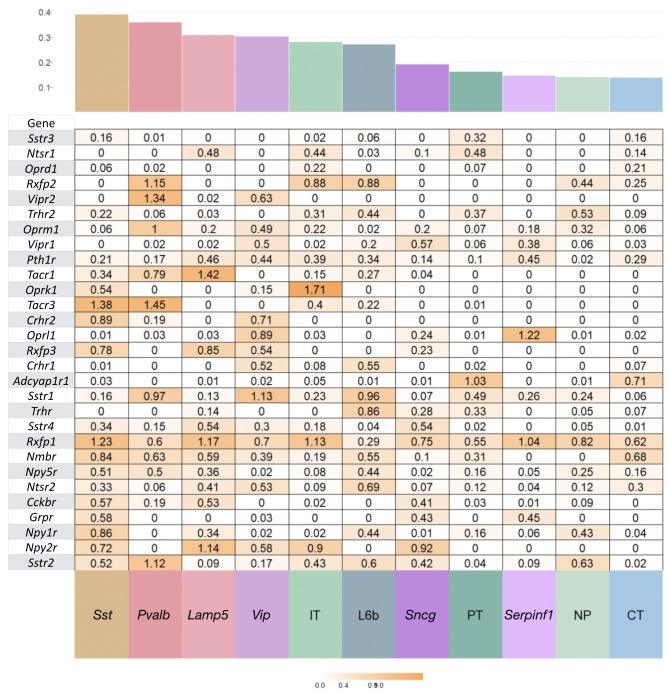
NP-GPCR expression variation within subclasses.Coefficient of variation (c.v. = standard deviation/mean) of expression for each NP-GPCR gene for Tasic et al., 2018 cell types pooled to 12 major types, glutamatergic types (IT, PT, NP, CT, L6b) and GABAergic types (Lamp5, Sncg, Serpinf1, Vip, Chodl, Sst, Pvalb). Mean c.v is a higher percentage of total c.v. for NP-GPCR compared to NPP genes.